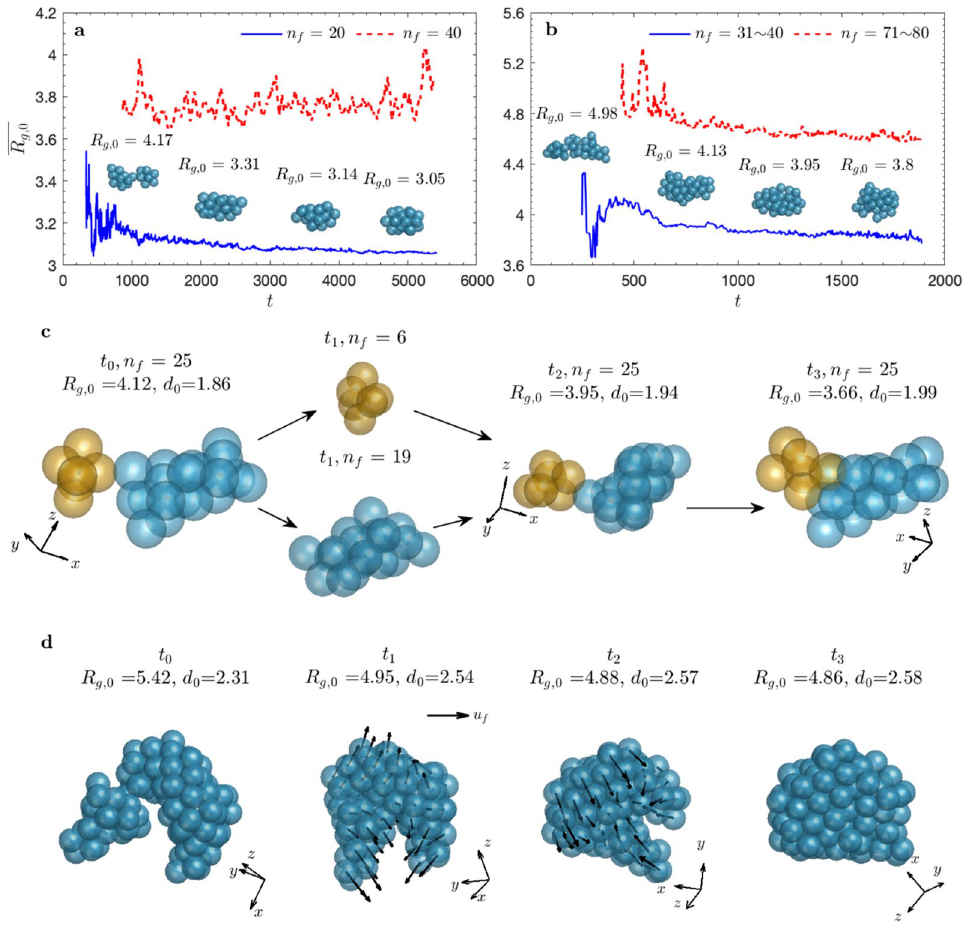
Figure 2. Floc reshaping by turbulence. ( a ) Time-evolution of mean radius of gyration ( R g ,0 ; see Method) of flocs consisting of 20 and 40 primary particles for case S1. Floc reshaping only takes place with smaller flocs as indicated by the decrease of R g ,0 with time. Four representative flocs with n f are plotted to shows how the mean floc structure changes with time. ( b ) The same for S2 of flocs consisting of 31–40 and 71–80 primary particles. Floc reshaping also influences larger floc size in S2. Four representative flocs 35 at different stages are plotted. ( c, d ) Two floc reshaping mechanisms, namely breakage-regrowth with n f = and restructuring by hydrodynamic drag, respectively. A floc of n f increased contact points after several breakage-regrowth sequences in ( c ). A large floc of n f goes through restructuring by hydrodynamic drag while all the particles stay connected in ( d ). The gap between two sub-flocs is closed by local converging flow indicated by the black arrows (local fluid velocity) at the particle